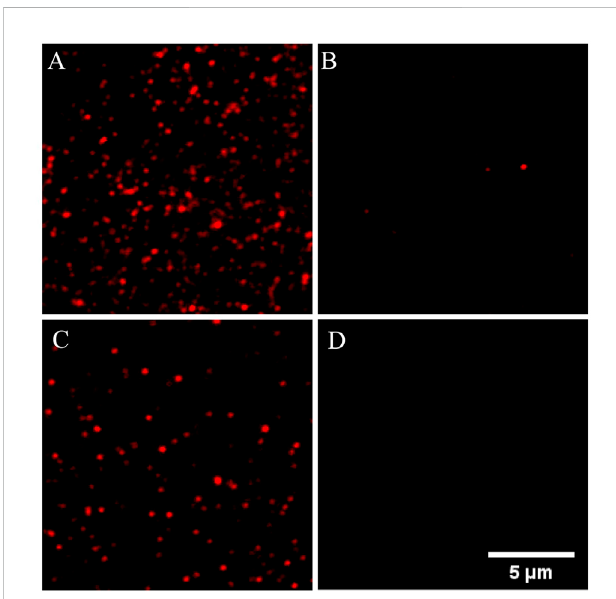
FIGURE 1 Different single-molecule fl uorescence imaging was shown in the PLL-PEG-Biotin-modi fi edsamplecellswithdifferenttreatments. (A) The modi fi ed sample cells were incubated with SA and probe 1. (B) The modi fi ed sample cells were incubated with SA and probe 1/2; (C) Above sample cell was used for miR-126 detection. (D) The modi fi